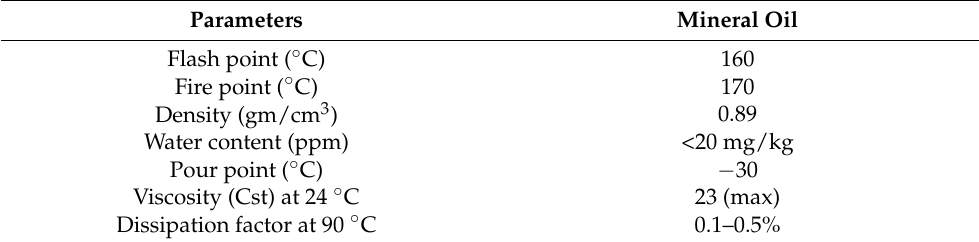
Table 2. Properties of Mineral oil.